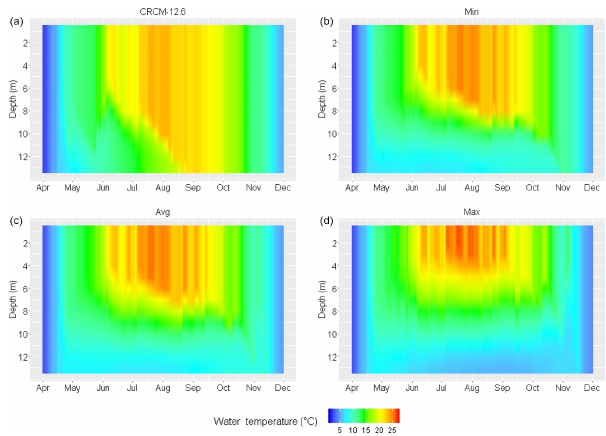
Figure 7. Isotherms in open water period 2008 for CRCM-12.6 ( K d = 0 . 2m − 1 ) simulation and the lowest (Min, K d = 0 . 58m − 1 ), average (Avg, K d = 0 . 90m − 1 ), and highest (Max, K d = 3 . 54m − 1 ) K d values are